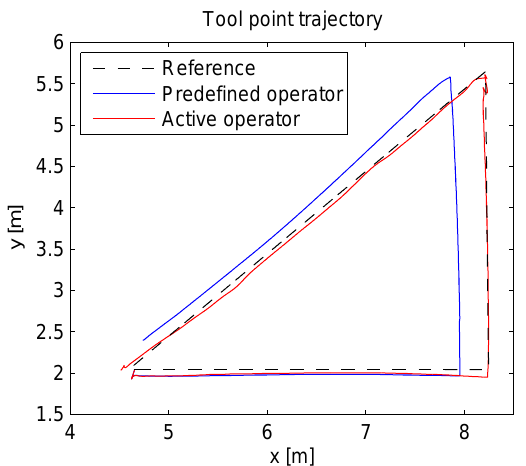
Figure 17: Reference and actual tool point